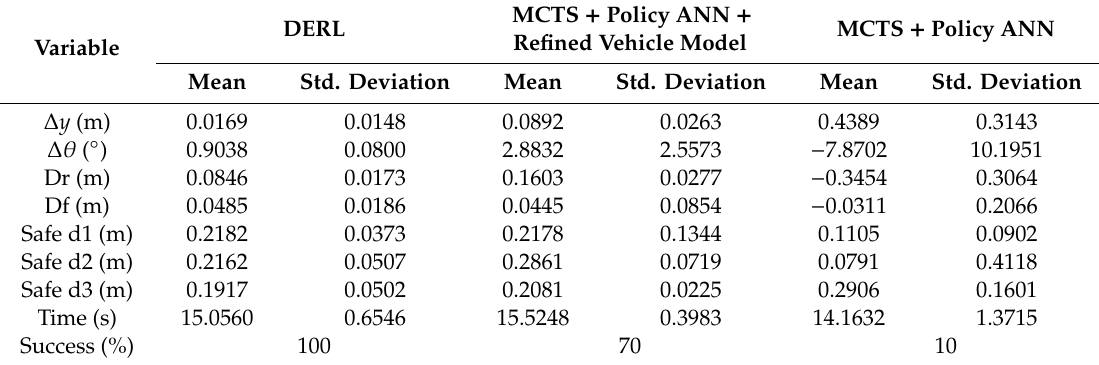
Table 4. Test results for changing initial poses for 20 × 3 parking trials.